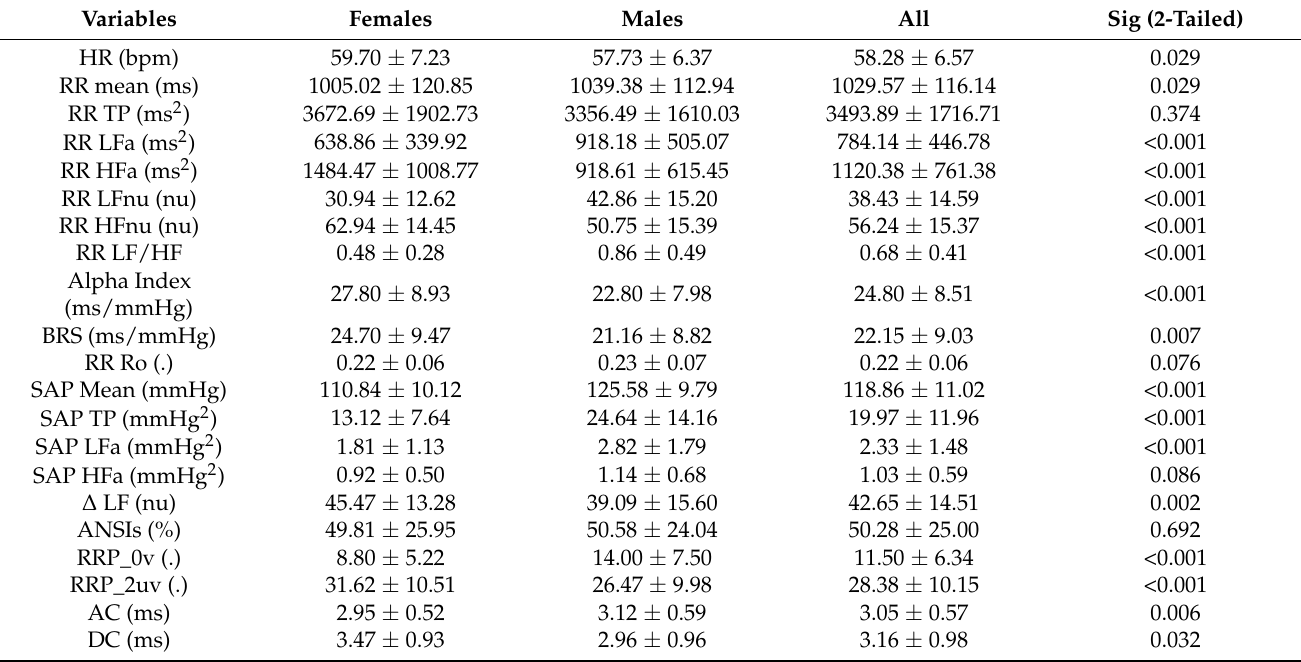
Table 5. Cardiac autonomic indices: summary statistics (median ± MAD) and Mann–Whitney